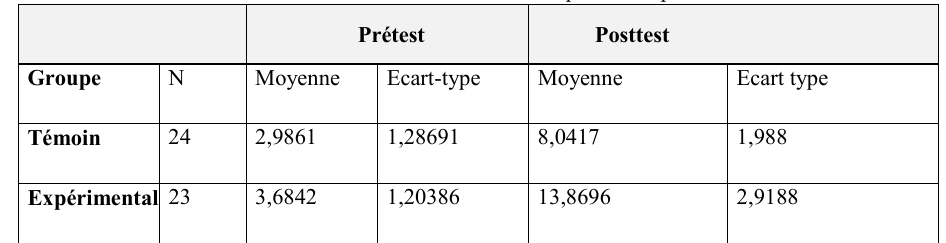
Tableau 2. Les conceptions des élèves qui ont été trouvées. Après l’apprentissage.